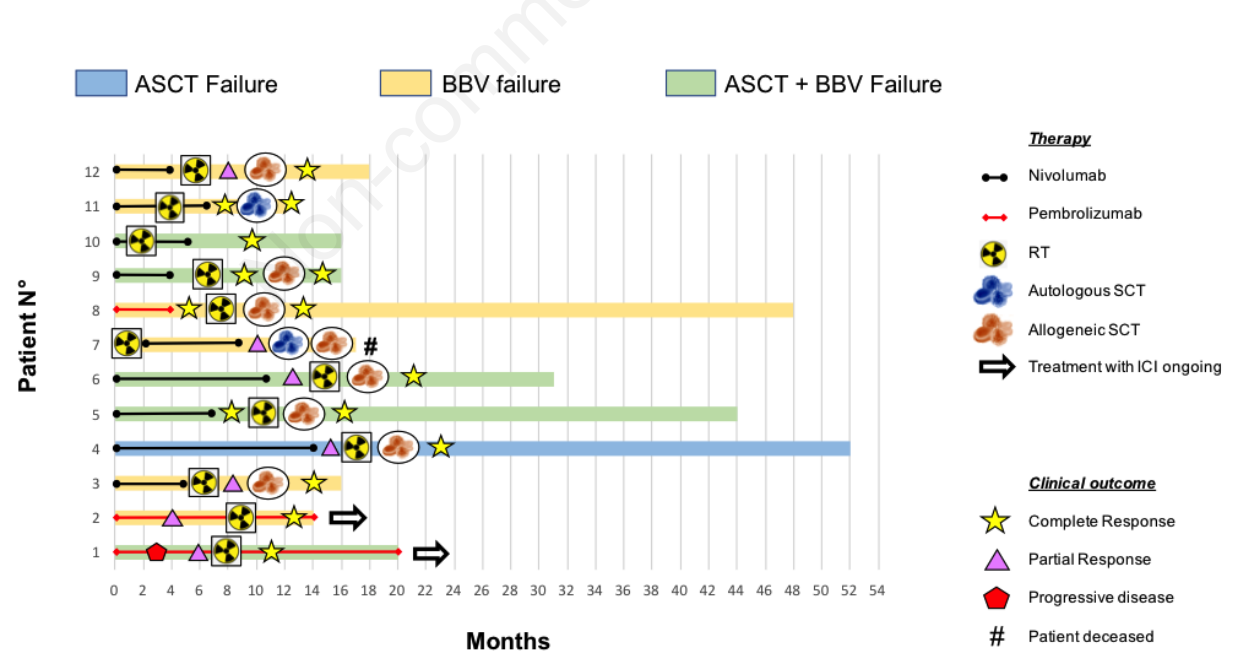
Figure 1. Treatment timing and duration and response onset for the 12 patients enrolled in the study. The color of each bar indicates whether previous autologous SCT and/or brentuximab vedotin (BV) therapy had failed in that patient. The length of the bar shows the observation time since the first day of combined therapy with ICI and RT. Nine patients discontinued ICI, after achieving response, in order to receive stem cell transplant consolidation. Two patients are still continuing ICI after achieving a complete metabolic response with combined ICI-RT. Eleven out of twelve patients are in complete remission at the time of this